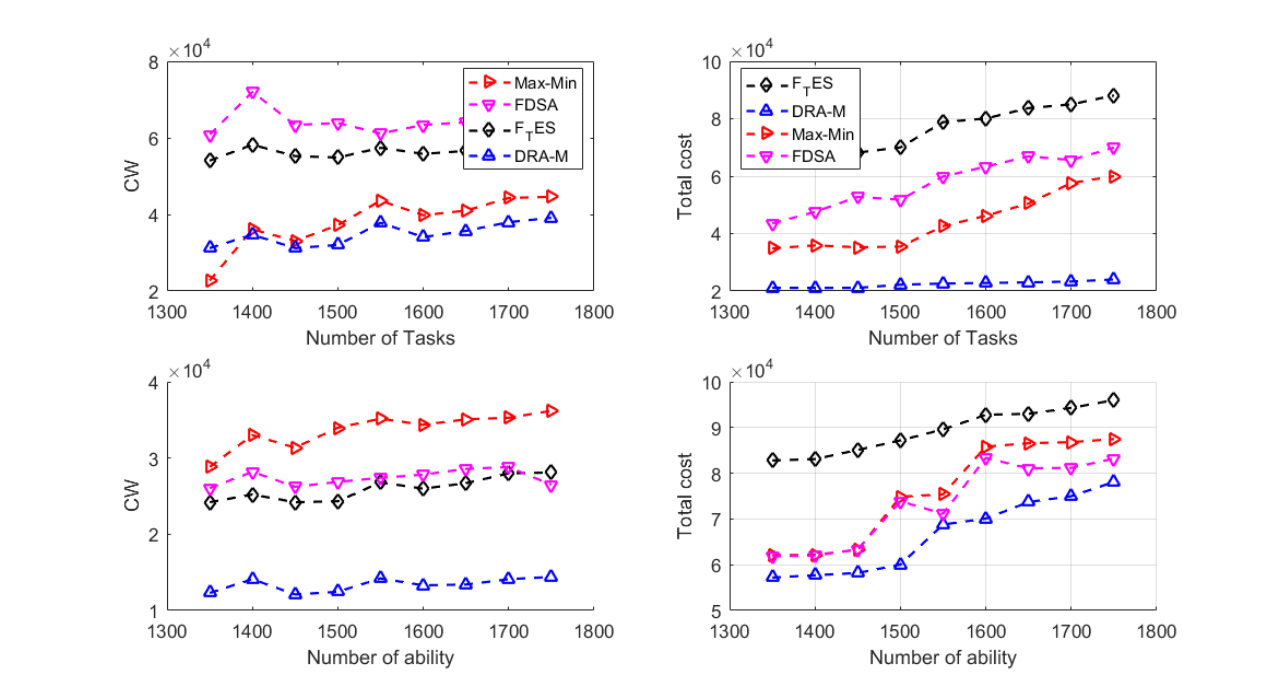
Figure 11. Comparison of algorithms for the same task and capability